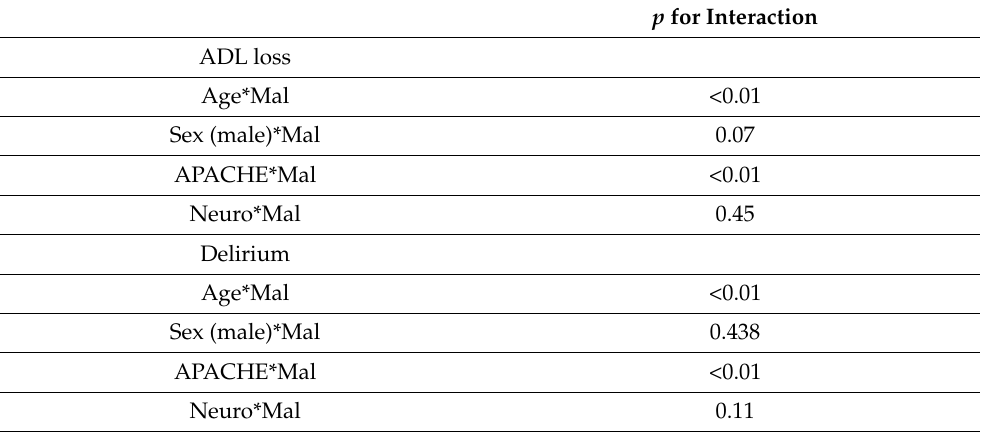
Table A3. The quantifications of the interaction between the variables of the multivariate